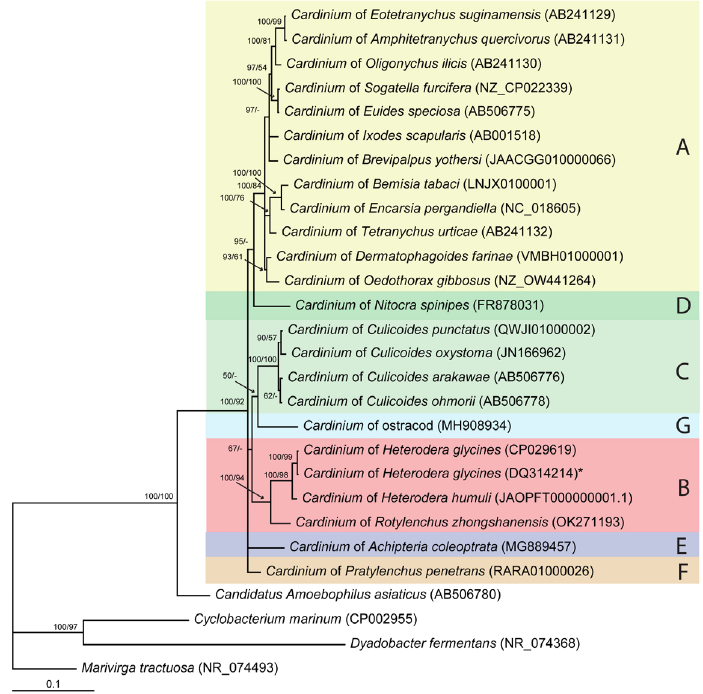
Figure 2. Phylogenetic relationships among representatives of Cardinium clade. Bayesian 50% majority rule consensus tree as inferred from 16S rRNA sequence alignment (alignment length-1464 bp) under the GTR + I + G model. Posterior probabilities (BI) and bootstrap values (ML) more than 50% are shown at branching points. *—Type strain of “ Candidatus Paenicardinium endonii”.